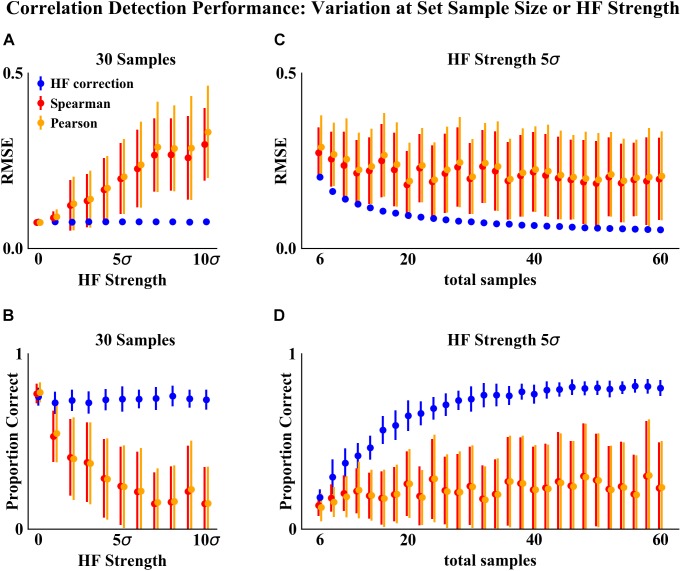
Correlation detection performance and variation on simulated data at set sample size or HF strength. (A,B) Set simulated sample size of 30 samples (15 samples for each habitat) and varying HF strength. (C,D) Set HF strength of 5σ and varying simulated sample size. Performance was measured based on two criteria: (A,C) RMSE between detected and simulated correlation matrices. (B,D) Proportion of correlations detected (at a significance cutoff of p < 0.01) corresponding to the initial randomly simulated correlations. Points indicate the mean and error bars indicate the standard deviation of 50 simulations.